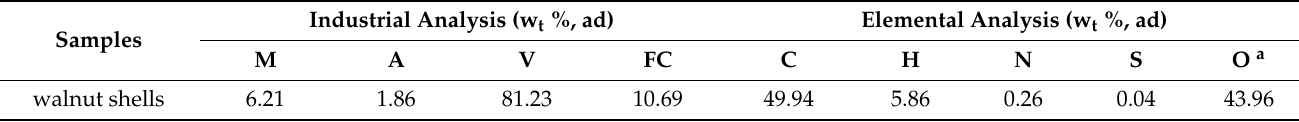
Table 1. Industrial analysis and elemental analysis of walnut shell.